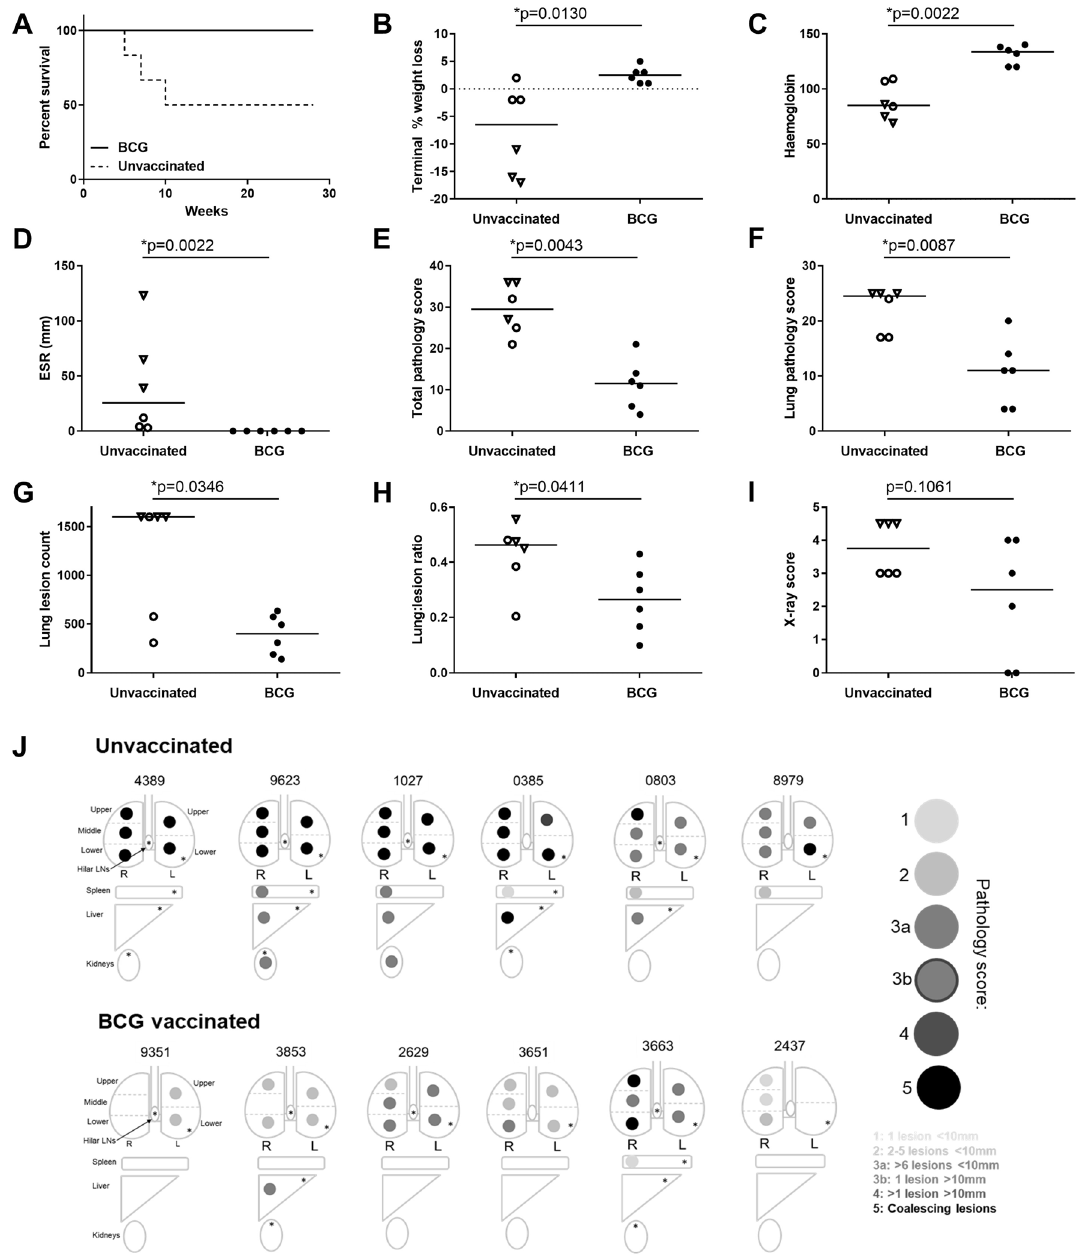
Figure 1. Measures of tuberculosis-induced pulmonary and clinical disease burden. ( A ) Kaplan Meier plot of survival of BCG vaccinated and unvaccinated NHPs after challenge with M. tb , (% weight loss from peak post- challenge weight on the day of euthanasia, ( C ) Red cell haemoglobin concentration on the day of euthanasia, ( D ) Erythrocyte sedimentation rate (ESR) on the day of euthanasia, ( E ) the total pathology score determined using a qualitative scoring system, ( F ) the score attributed to the pulmonary component as part of the total pathology; ( G ) number of lesions in the lung enumerated by serial sectioning and manual counting, ( H ) the lung to lesion volume ratio determined using MR stereology, ( I ) score attributed to the chest radiogram on the day of euthanasia. Graphs B-I medians shown. Black symbols = BCG vaccinated, open symbols = unvaccinated. Triangle symbols indicate animals in which disease reached levels that met endpoint criteria. p values are shown and *denotes significant difference in outcome between groups using the non-parametric Mann–Whitney U test, p ≤ 0.05. ( J ) representative diagram of the location and number of granulomas present in the lungs, hilar lymph nodes, spleen, liver and kidneys and *show where M. tb bacteria were isolated and cultured